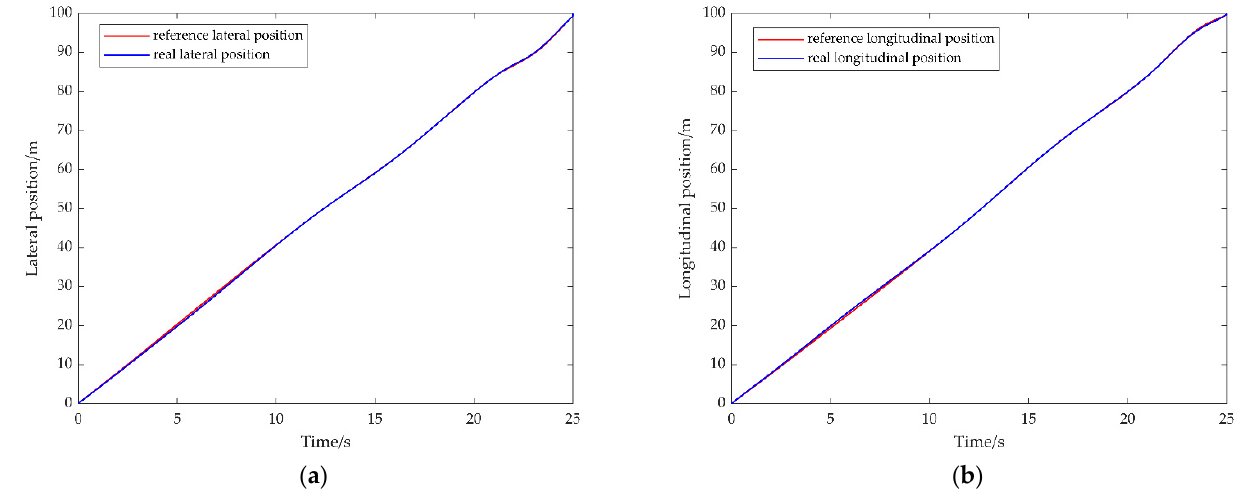
Figure 3. ( a ) Comparison of the lateral position of the reference track and the real track; ( b ) compar ‐ ison of the longitudinal position of the reference track and the real